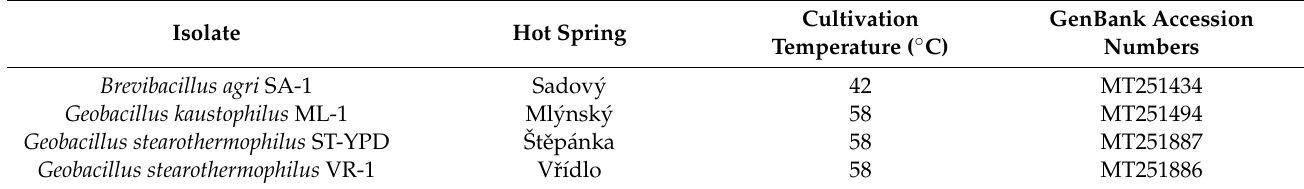
Table 1. List of the cultivated bacterial isolates from four springs of Carlsbad (Karlovy Vary), Czech Republic. Isolate